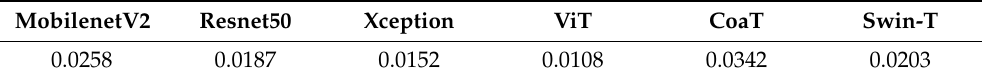
Table 6. Convolutional neural network (CNN) classifier’s average time test (ATT) (s).